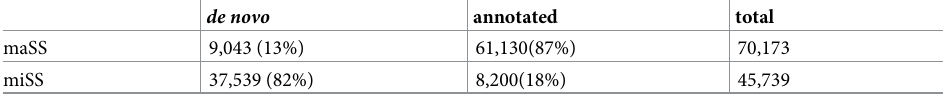
Table 2. The fractions of annotated and de novo sites among maSS and